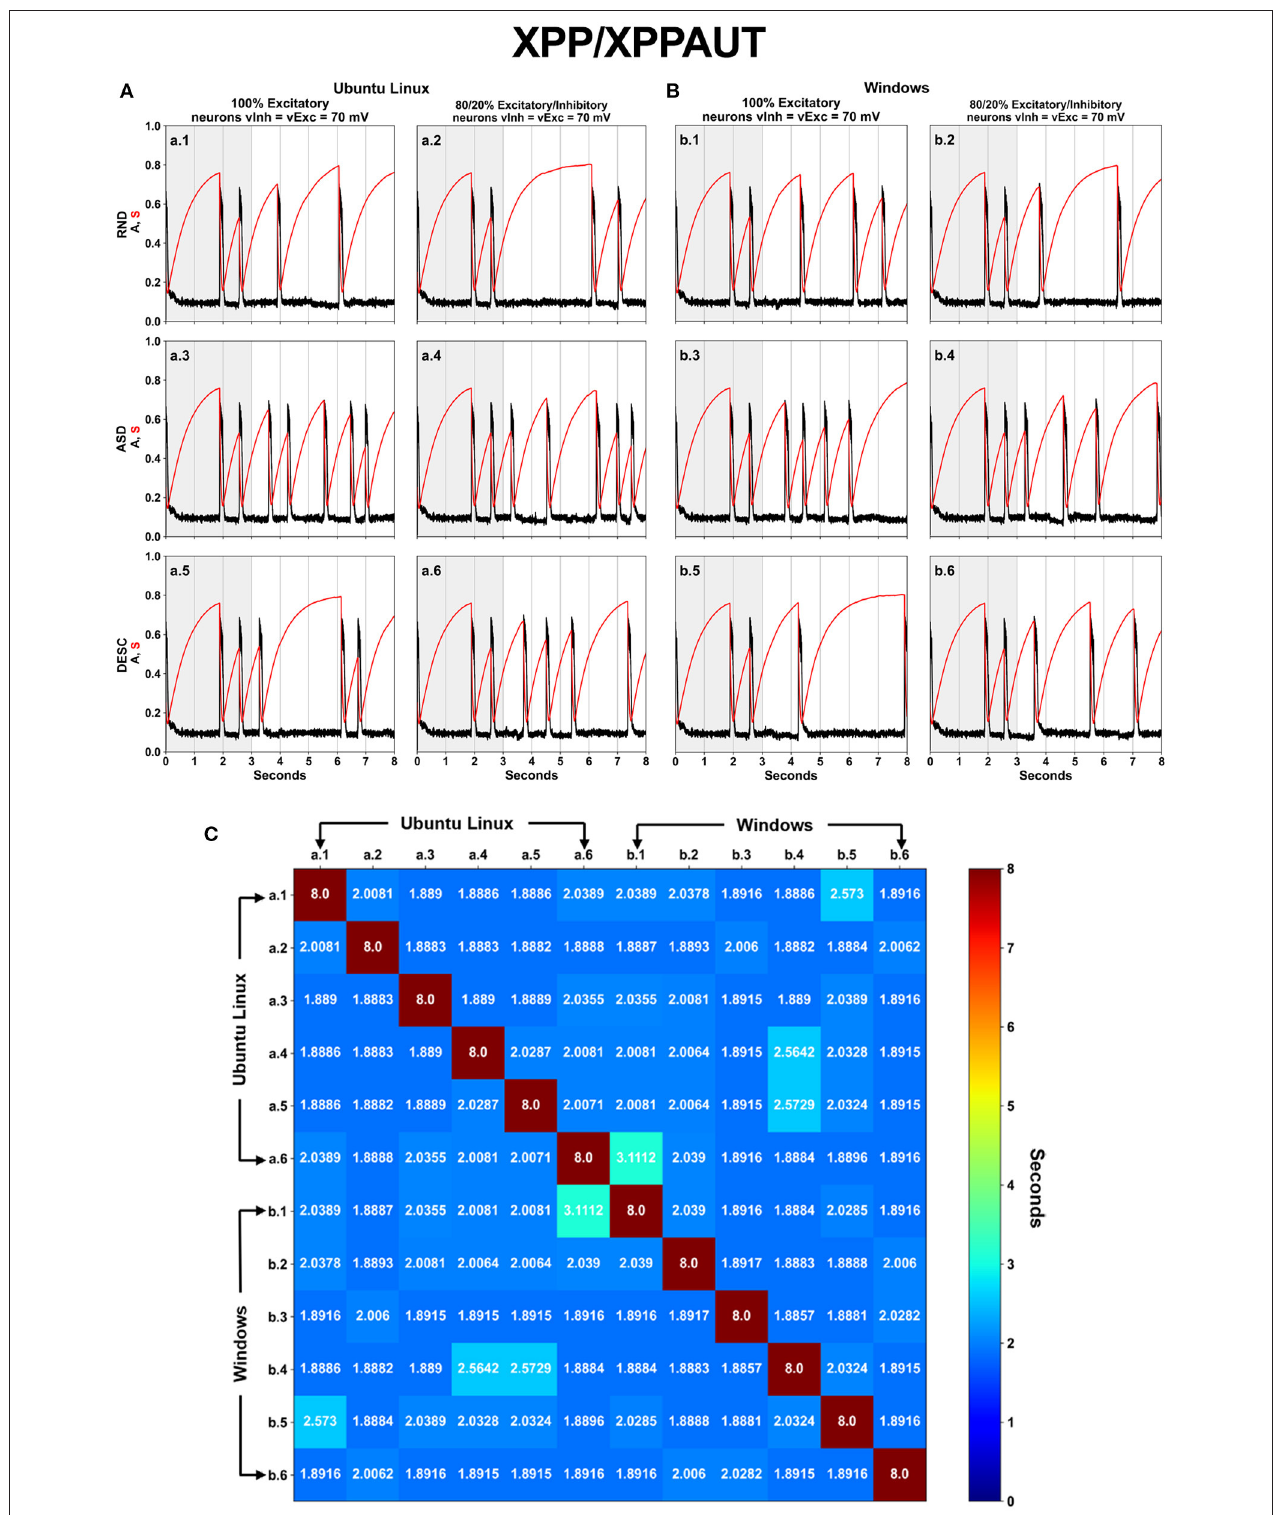
FIGURE 2 | Associations and commutations of the Iapp vector produced different results on XPP/XPPAUT. The spontaneous network activity < A > (black curve) and the network synaptic efficacy < S > (red curve) are shown for a total of twelve (12) scenarios, which are the six (SPLT × SORT − 2 × 3) scenarios shown in Figure 1 for Ubuntu Linux (A) and for Windows (B) . Panel (C) displays a square matrix with an all-to-all comparison of these 12 scenarios based on the absolute error between simulations. Each cell represents the first moment in time (seconds) when the absolute error reached a value > 10 − 4 .